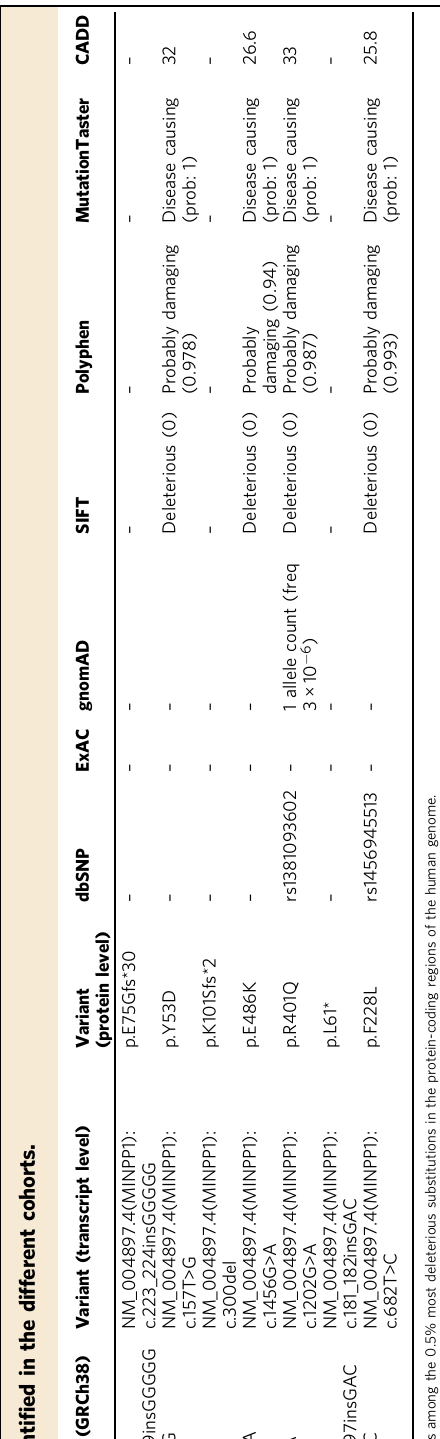
difference in the binding of the apoptosis marker Annexin-V (Fig. 2d, Supplementary Fig. 2b, c). This defect was partially res- cued by transient overexpression of WT MINPP1 ( p = 0.0029; Fig. 2e, Supplementary Fig. 2d). Contrastingly, overexpression of two of the MINPP1 missense variants (i.e., Y53D and E486K) did not rescue growth, suggesting that these variants have a major impact on the protein function. MINPP1 has two predicted N- glycosylation sites (Fig. 1d). In order to evaluate the glycosylation status of the endogenous and over-expressed WT MINPP1 as well as the Y53D and E486K missense variants, we treated the protein extract with the PNGase enzyme 32 . A shift in the molecular weight after treatment, in all the samples, indicated that MINPP1 is indeed glycosylated without major impact of the missense variants (Supplementary Fig. 2e). Patient and genome-edited MINPP1 mutant neural progeni- tors show an impaired neuronal differentiation with increased apoptosis . To investigate the mechanism at the origin of the neurological symptoms of MINPP1 patients, we derived induced pluripotent stem cells (iPSCs) from patient CerID-30-2 T